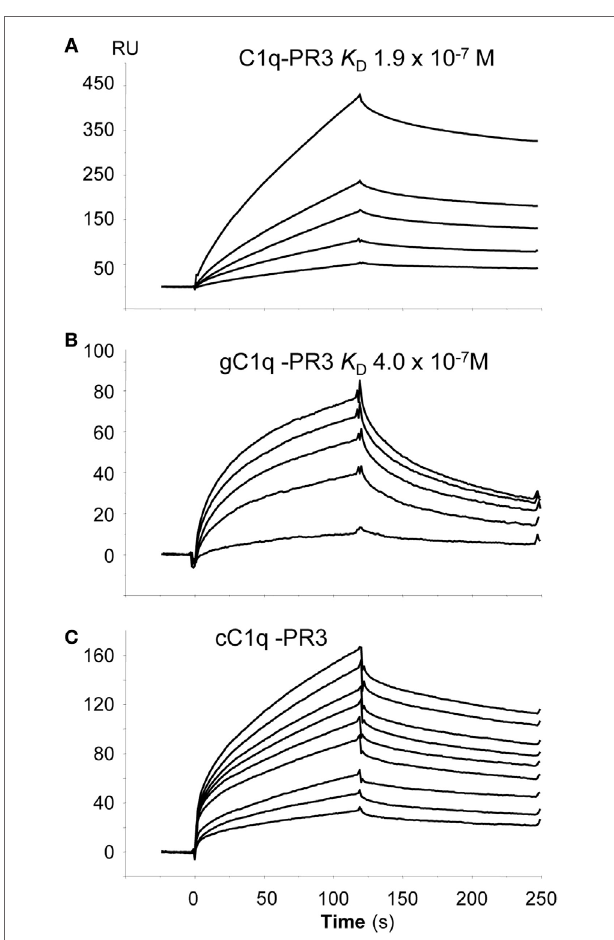
FigUre 3 | Globular region of C1q (gC1q) and collagenous-like fragment of C1q (cC1q) fragments bind to proteinase 3 (PR3). Binding of intact C1q (a) , of the globular C1q heads, gC1q (B) , and of the collagen tail of C1q, cC1q (c) to immobilized PR3. All interactions were measured in the running buffer at a flow rate of 20 µl/min. Association and dissociation curves were each recorded for 120 s. The concentrations of soluble ligands were as follows: C1q: 0.05, 0.10, 0.20, 0.30, and 0.50 µM; gC1q 0.10, 0.40, 0.70, 0.80, and 1.0 µM; cC1q 0.3, 0.4, 0.5, 0.7, 0.8, 0.9, 1.0, 1.2, and 1.4 µM. The kinetic parameters of the interactions were determined by recording sensorgrams at varying concentrations are listed in Table 1 . All other conditions are described in Section “Materials and Methods.”